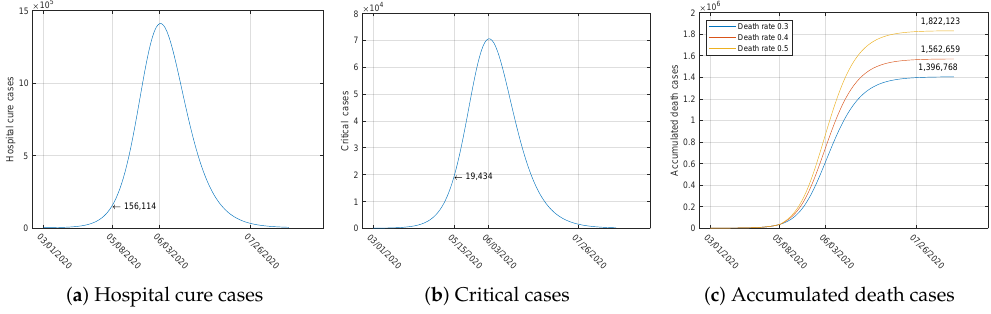
Figure 5. Forecasts of the number of hospital cure cases, critical cases, and accumulated death cases.